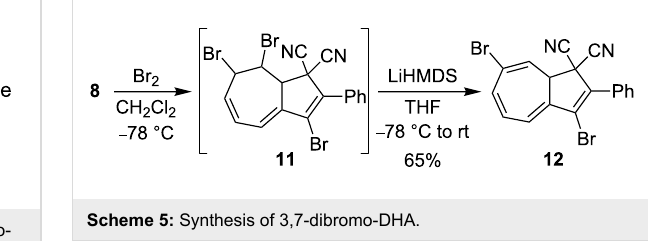
Figure 5: Compound 9 was selectively brominated to furnish the pro- duct 10 .